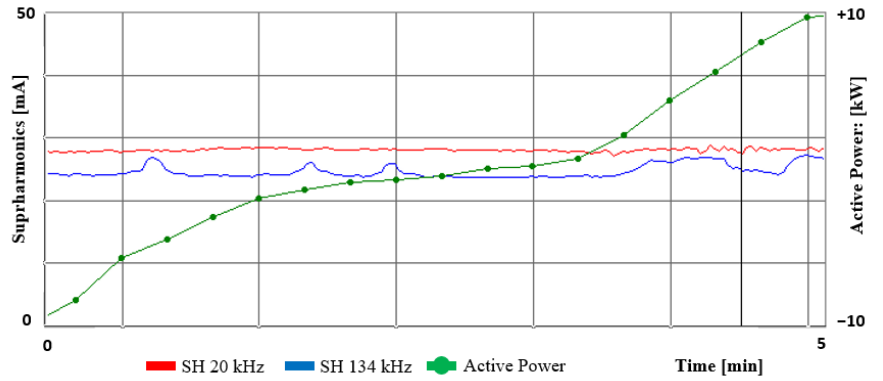
Figure 13. Supraharmonic emissions at 20 kHz and 134 kHz depending on charging-discharging power [14].